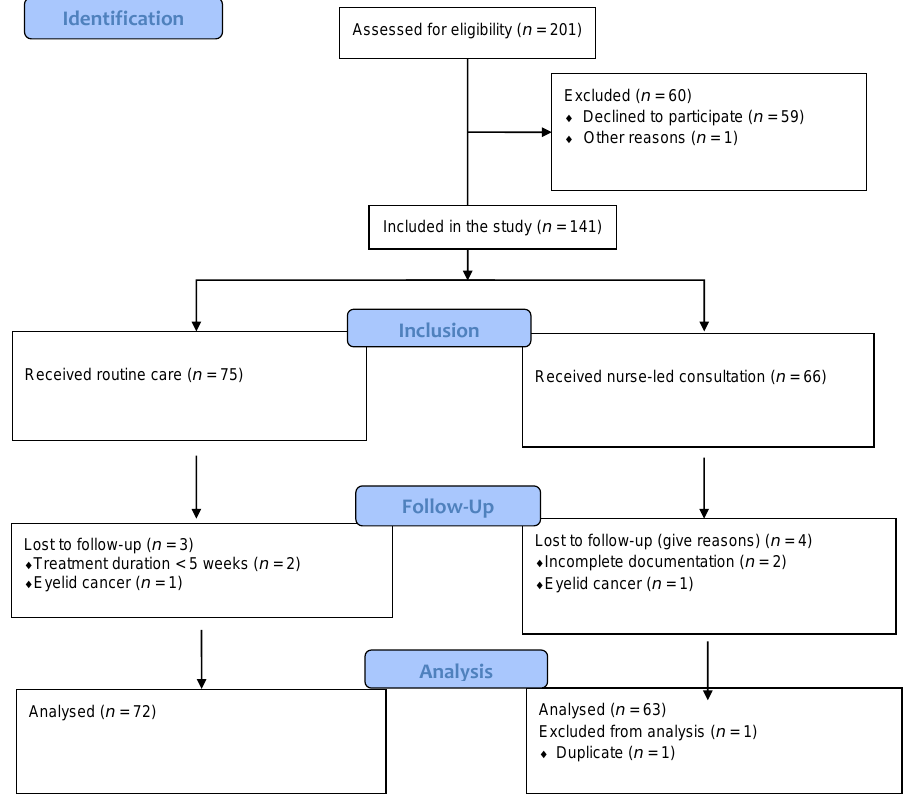
Figure 1. Participant enrolment